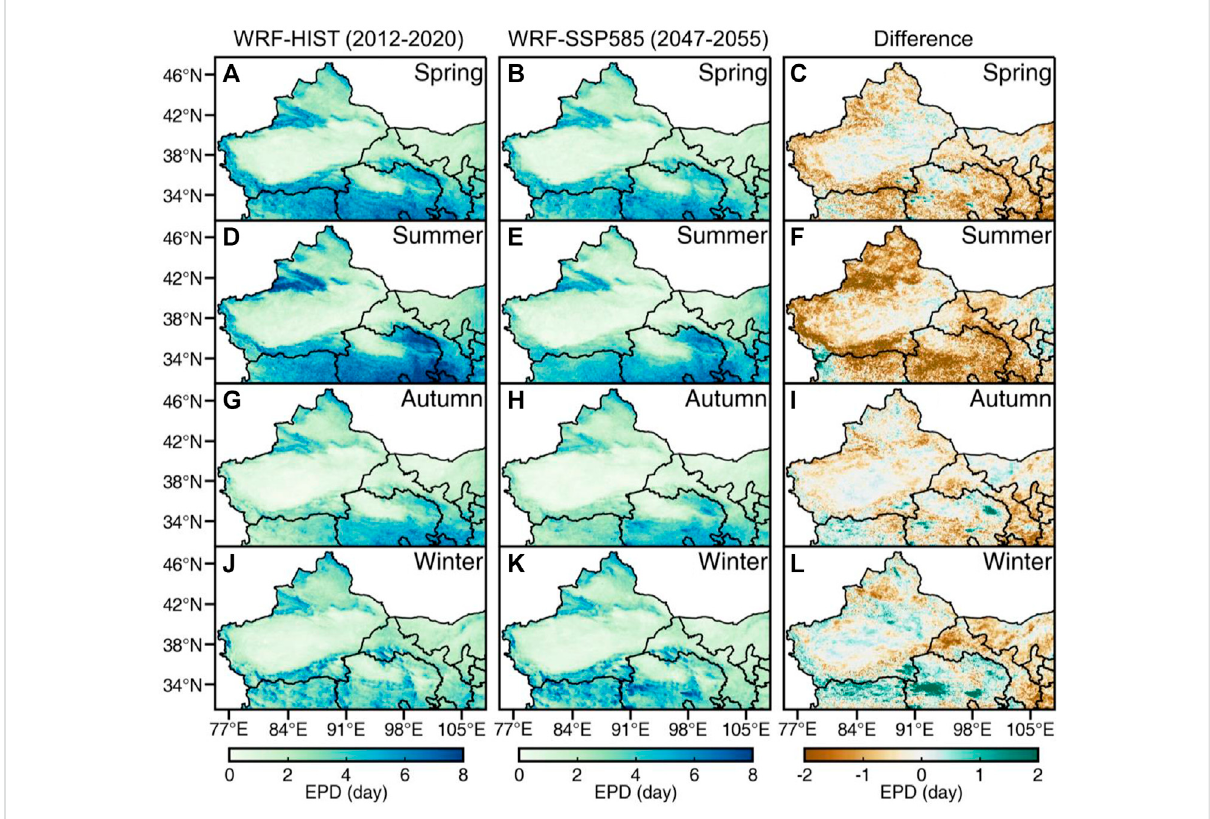
FIGURE 8 Multi-year seasonal average extreme precipitation days (EPD) and corresponding changes simulated by WRF-HIST (2012 – 2020) and WRF- SSP585 (2047 – 2055) experiments over Northwest